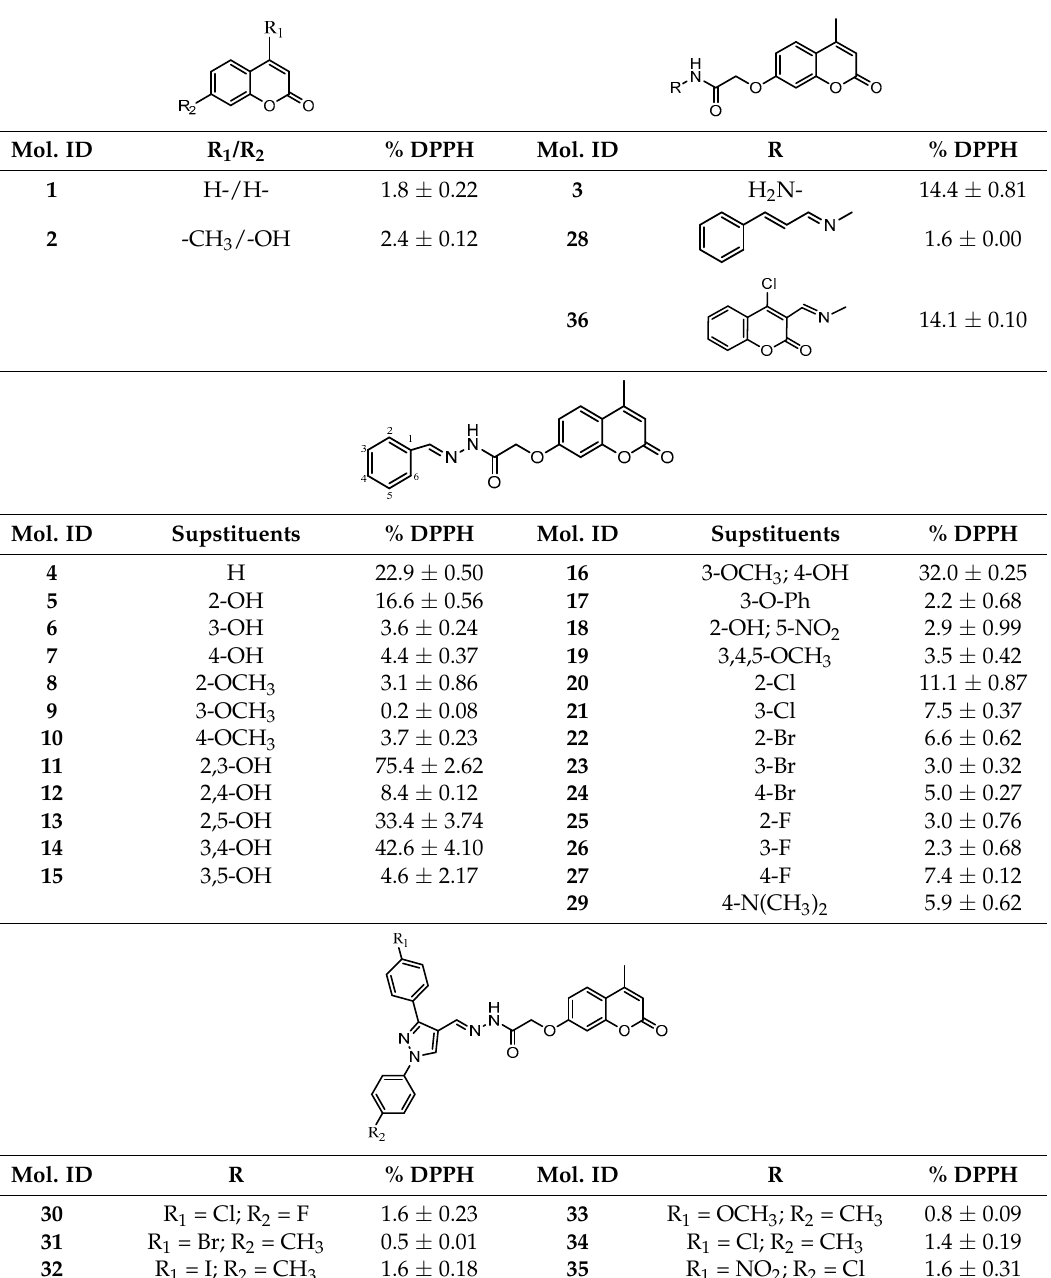
Mol. Mol. ID Mol. ID Mol. ID Mol. ID Mol. ID